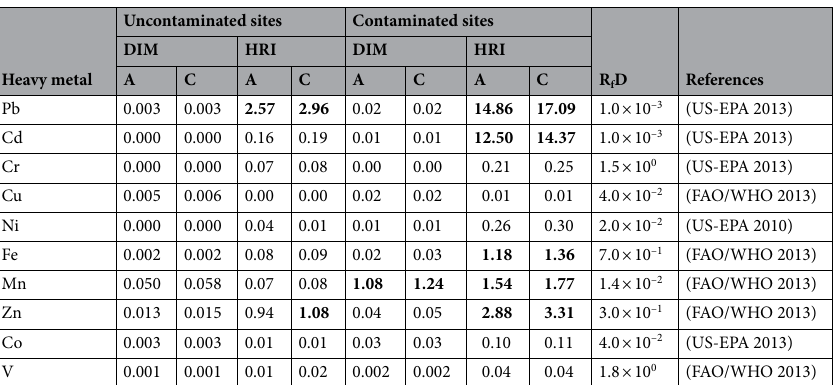
Table 7. Individual heavy metals in the edible sections of eggplants planted in uncontaminated and contaminated soils using the daily intake of metals (DIM: mg day1) and the health risk index (HRI) of adults (A) and children